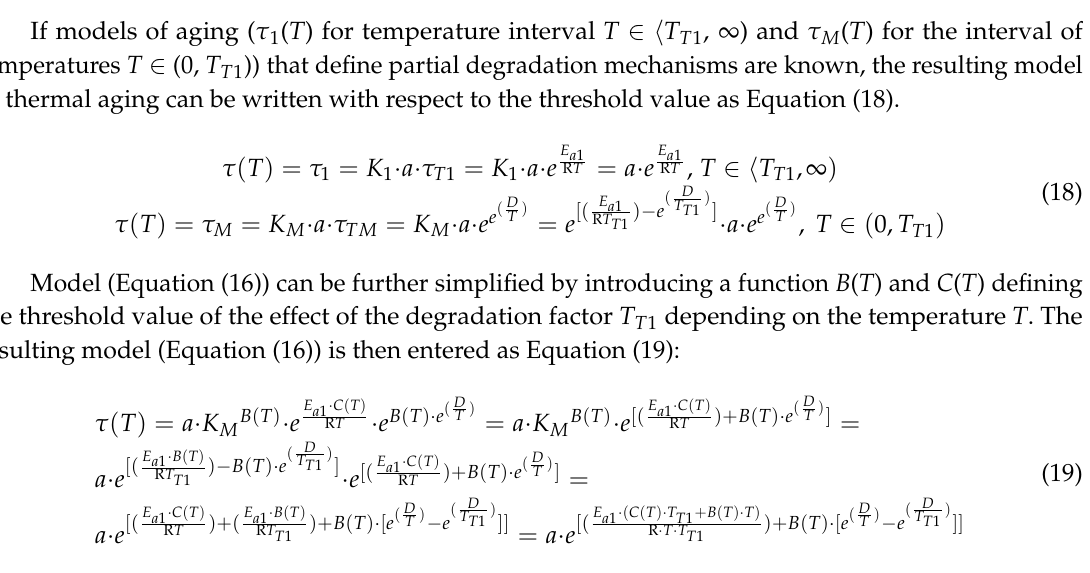
Figure 4. The course of thermal aging model that respects limit state of the effect of the degradation factor in logarithmic scale.